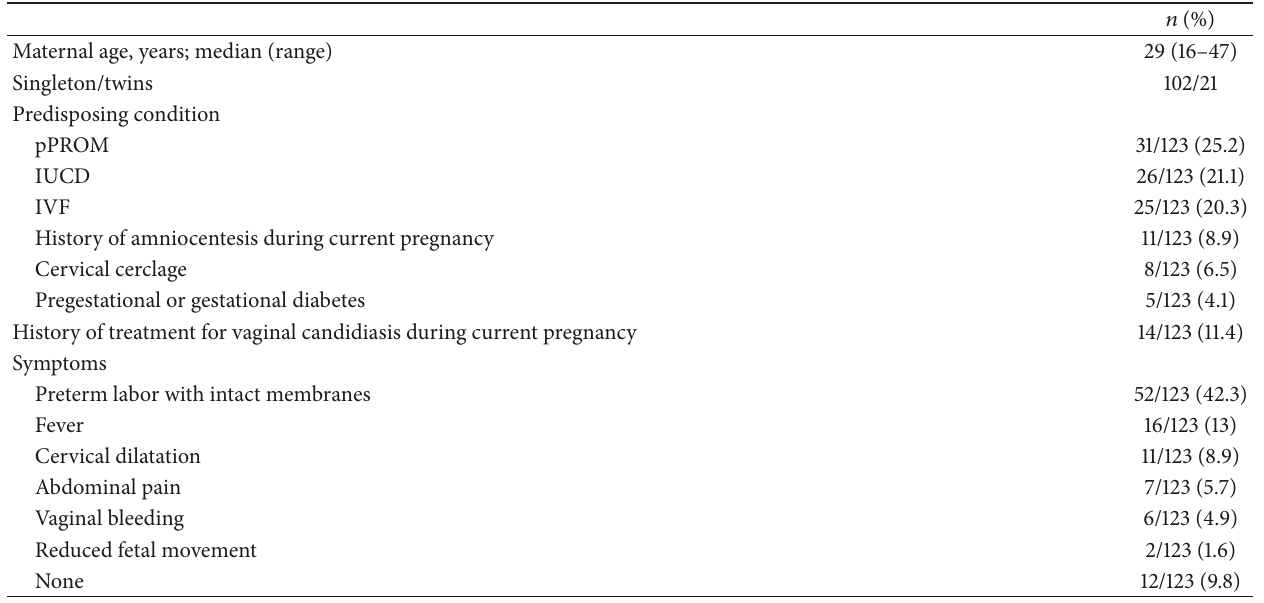
Table 3: Maternal clinical features in the literature review.